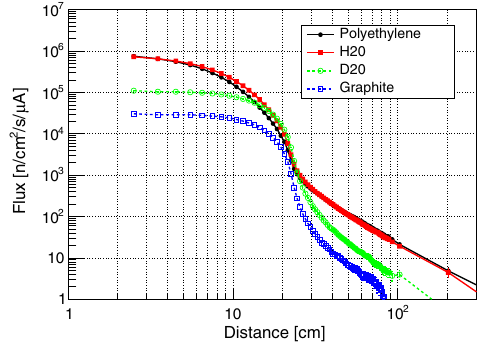
Figure 1: Sketches of the 2016 (left) and 2019 (right) TMR experimental configurations. The origin of the distance to neutron detectors is also indicated.